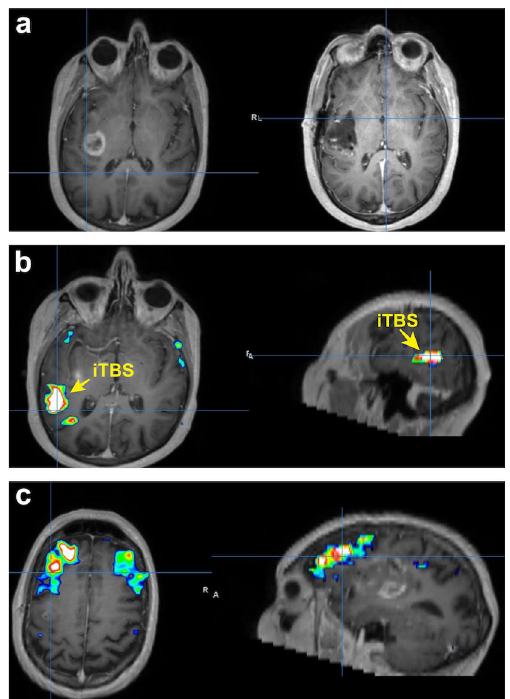
Figure 6. TMS strategy for patient presenting with moderate expressive aphasia secondary to glioblastoma. ( a ) Preoperative MRI (left) demonstrating left insula glioblastoma and postoperative MRI (right) demonstrating complete resection. ( b ) Network analysis demonstrating a strongly organized posterior temporal region that is not in in the same network as Broca’s area. This was the area that was selected for treatment with iTBS. ( c ). Further network analysis demonstrating Broca’s area with bilateral representation that is not in the same network as the posterior temporal